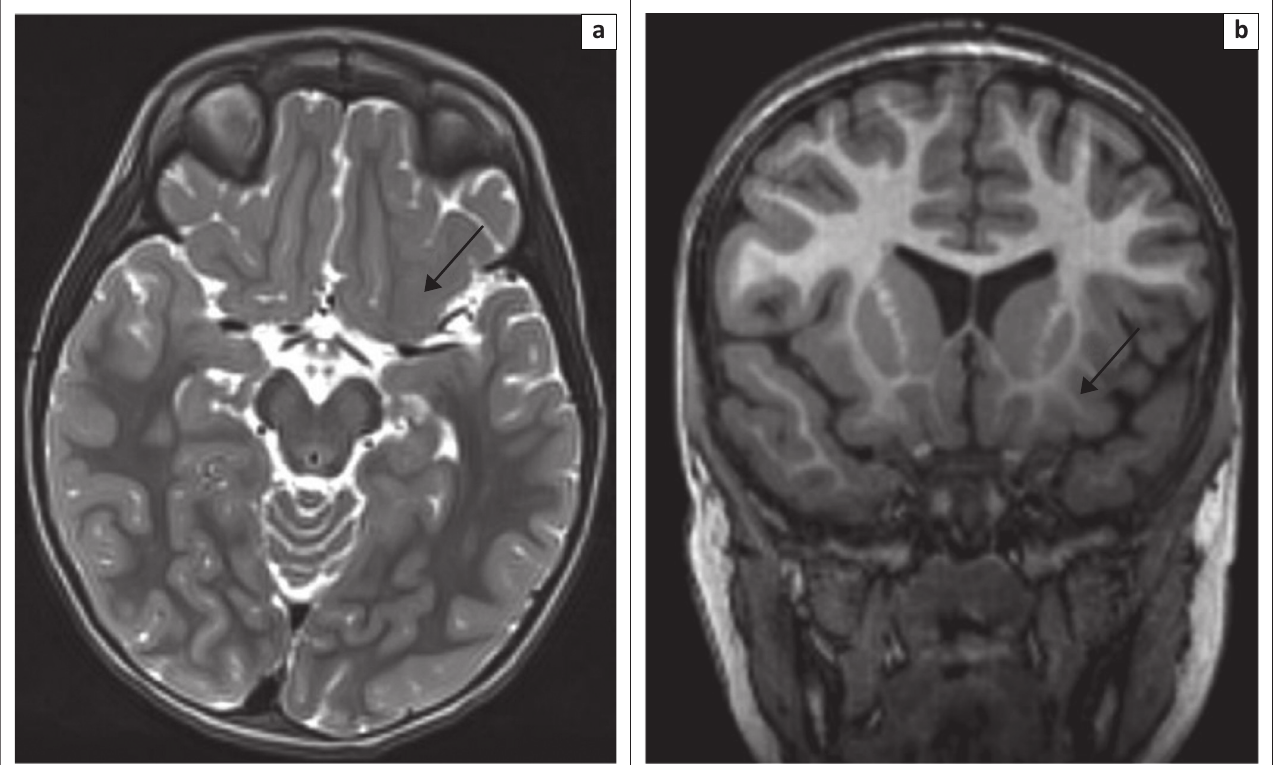
FIGURE 1: Three-year-old girl with pharmaco-resistant left frontal lobe epilepsy. Axial T2W (a) shows focal thickening of the cortex in the posterior orbital gyrus in the left inferior frontal lobe (arrow) extending into the anterior aspect of the insula and inferiorly to the junction of the insula and anterior aspect of the superior temporal lobe gyrus. Coronal MPRAGE (b); note the mildly increased T1 signal of the affected cortex and blurred gray and white matter interface (arrowhead). Resected specimen showed focal regions of dyslamination of the cortex and moderate to severe reactive gliosis in keeping with FCD Type